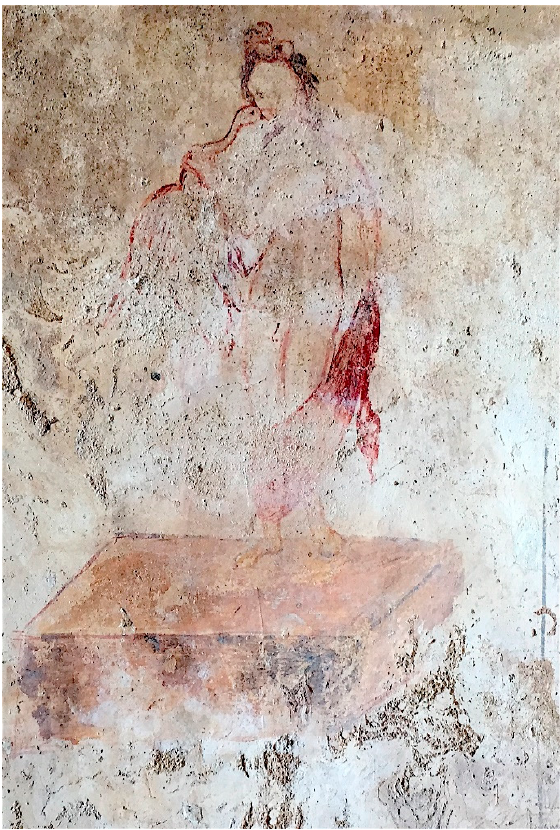
Figure 9. Soluntum, House of Leda, triclinium g, detail of Leda panel (photo by the author).